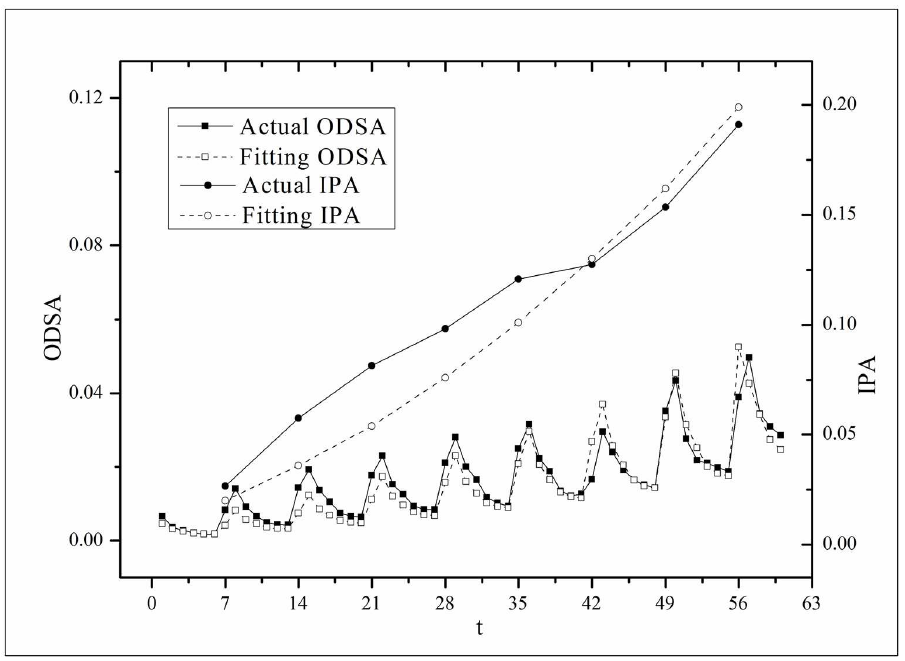
Fig 3. Two-step fitting results for the Masters